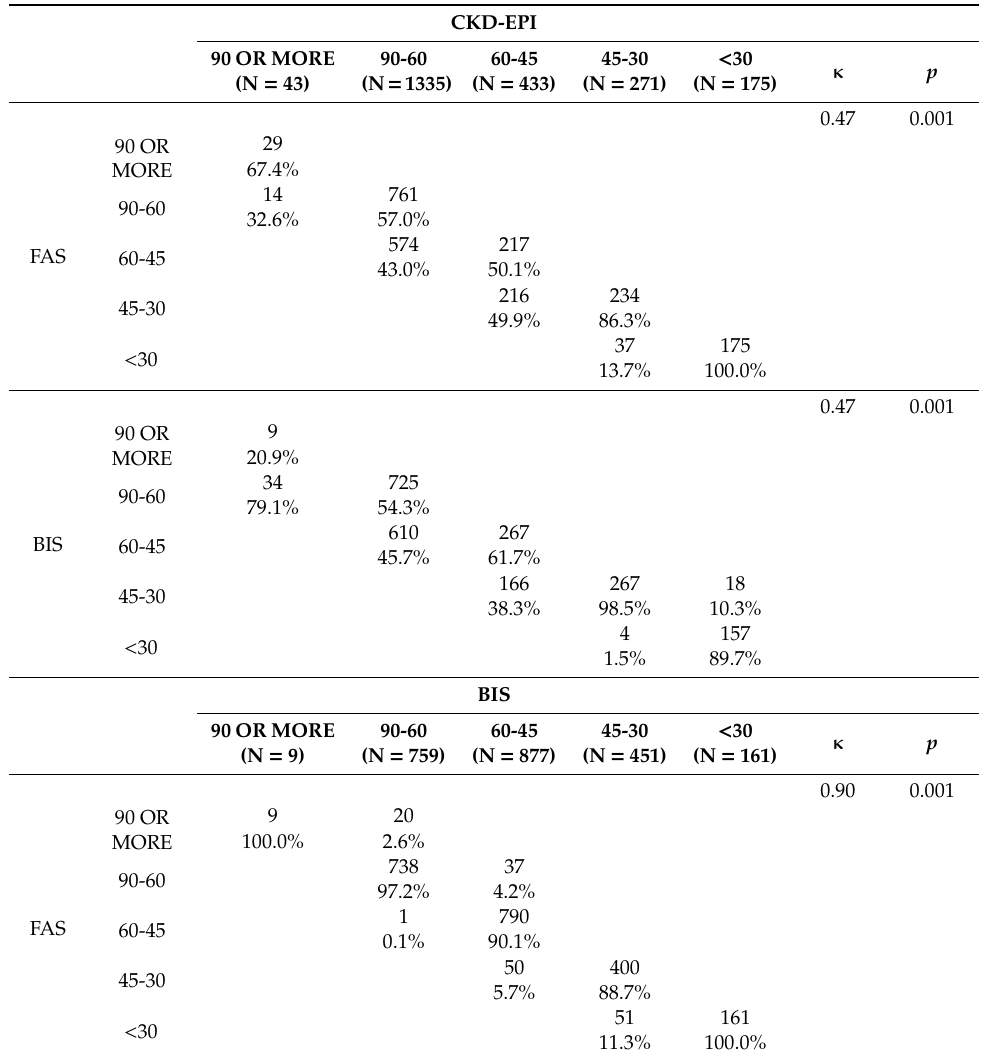
Table 4. Agreement among eGFR equations studied for the whole group of participants of the SCOPE